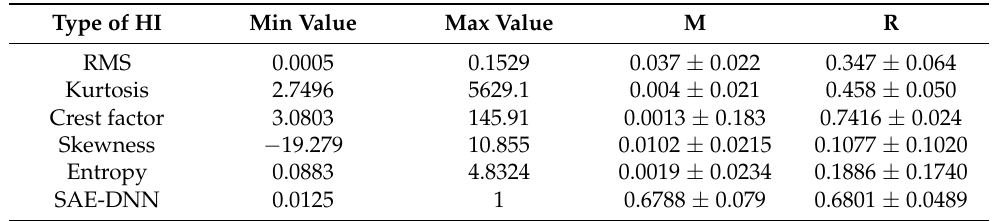
Table 2. Metric comparison of different types of HIs.